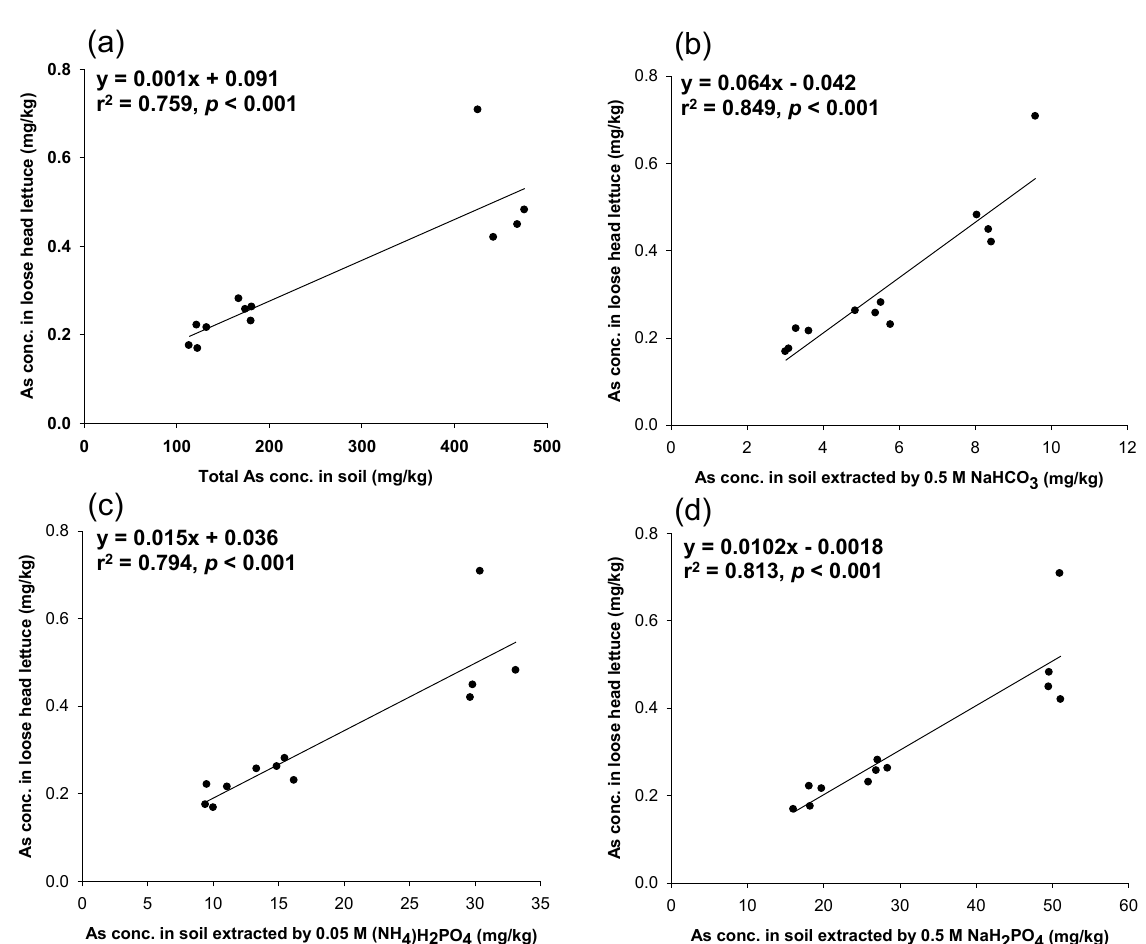
Figure 2. The relationship between As concentrations in loose head lettuce and in soils extracted with ( a ) HNO NaH PO . 2 4